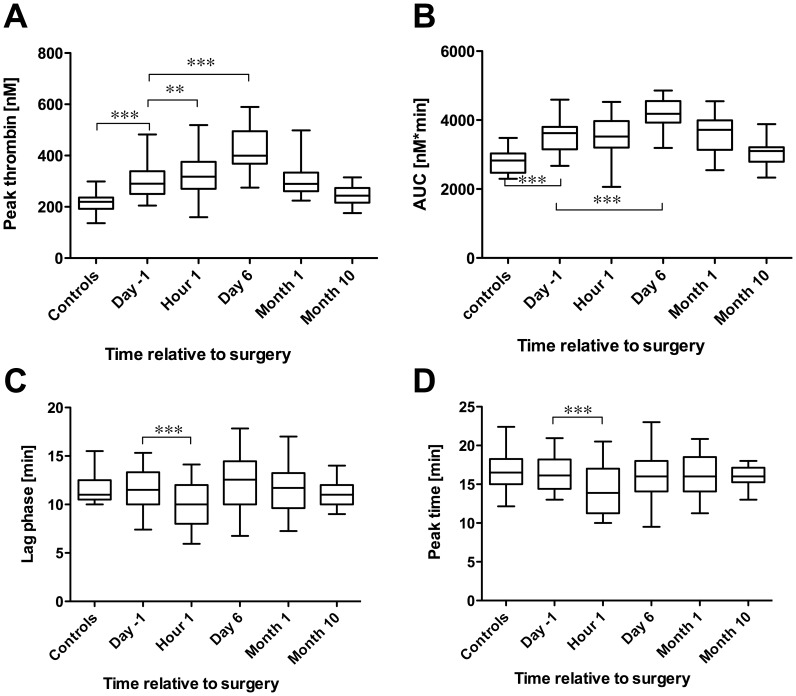
Thrombin generation parameters: Whiskers: 5–95 percentile graphs of peak thrombin (A), area under the curve (B), lag time (C) and peak time (D).Labels of significance: *p<0.05, **p<0.01, ***p<0.001.